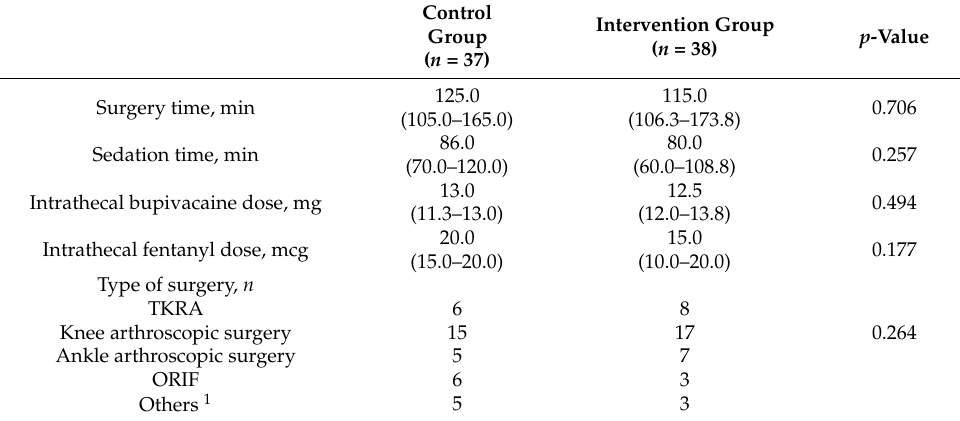
Table 2. Operational data.